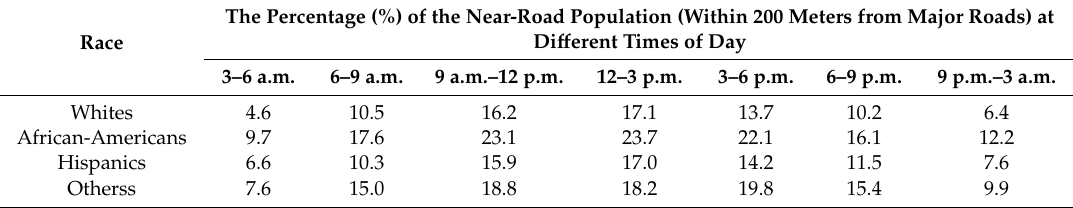
Table 4. The percentage (%) of the near-road population at different times of day (by race). The Percentage (%) of the Near-Road Population (Within 200 Meters from Major Roads) at Different Times of Day Race